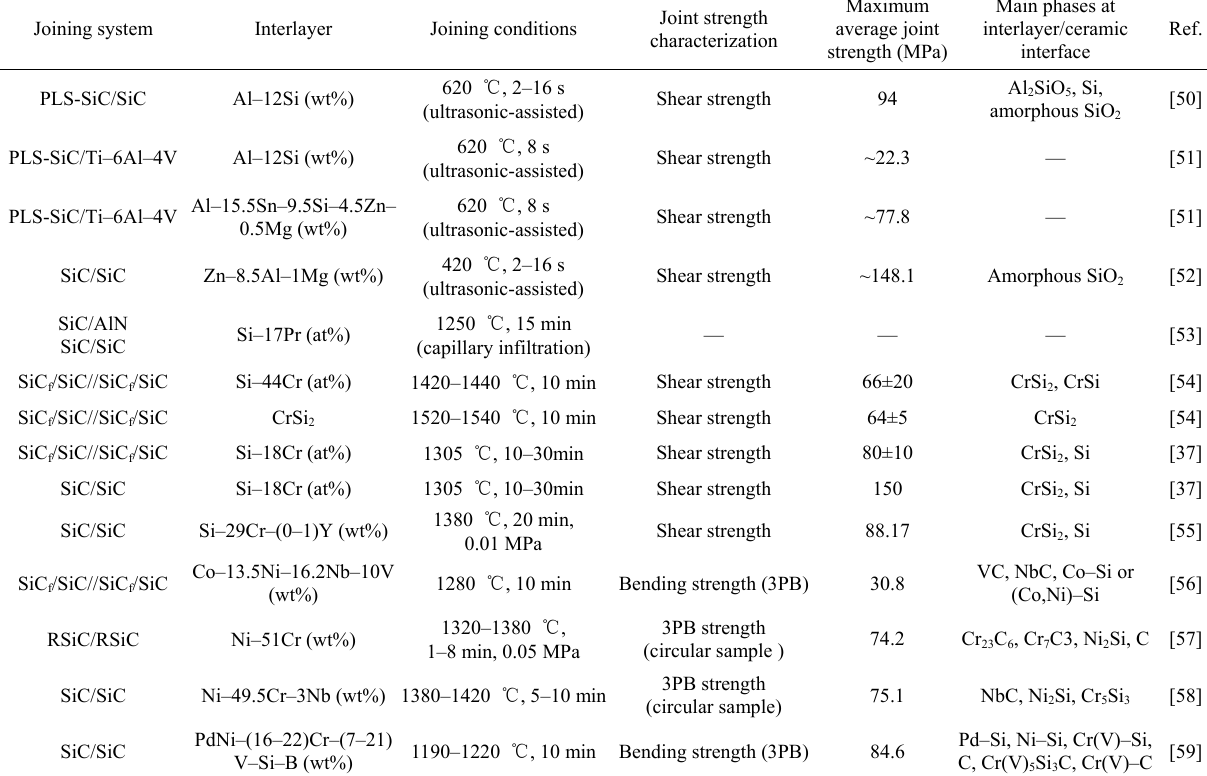
Fig. 6 Interfacial microstructures of SiC/SiC joints brazed using active filler metals of (a) Ag–Cu–Ti and (b) Ag–Cu–In–Ti, showing the presence of TiC and Ti 5 Si 3 at the interfaces. Reproduced with permission from Ref. [41], © Elsevier Ltd and Techna Group S.r.l. 2009; Ref. [43], © The Author(s) 2014. Table 3 Brazing of SiC-based materials using Ti-free brazing fillers: interlayer, joining conditions, joint strength, and main phases at interlayer/ceramic